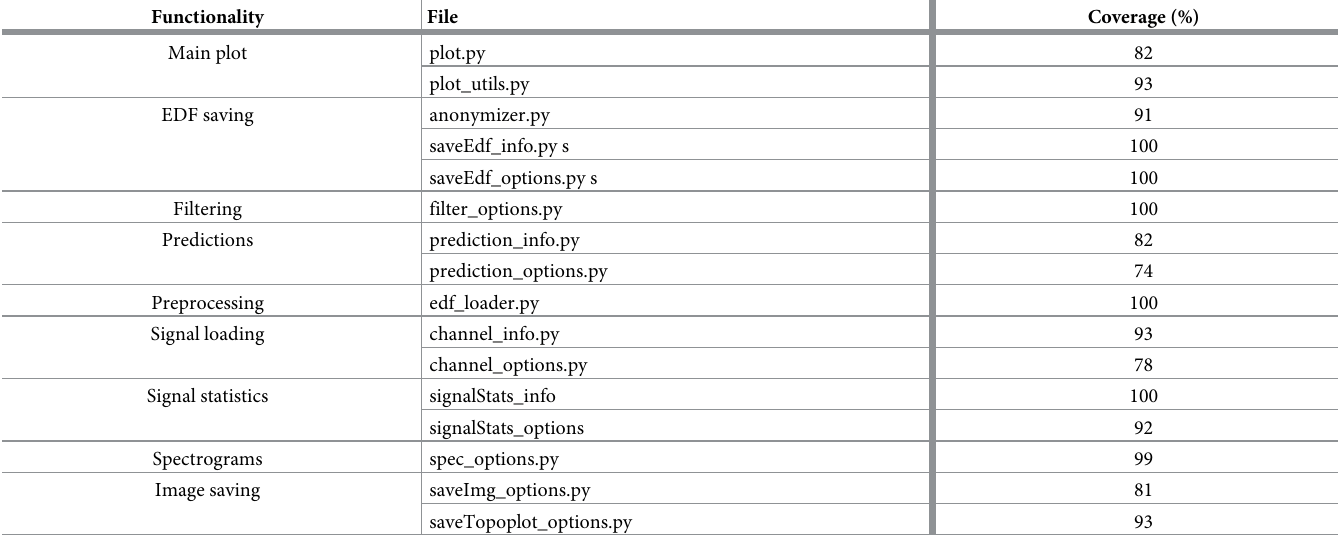
Table 1. Unit testing code coverage for EPViz source